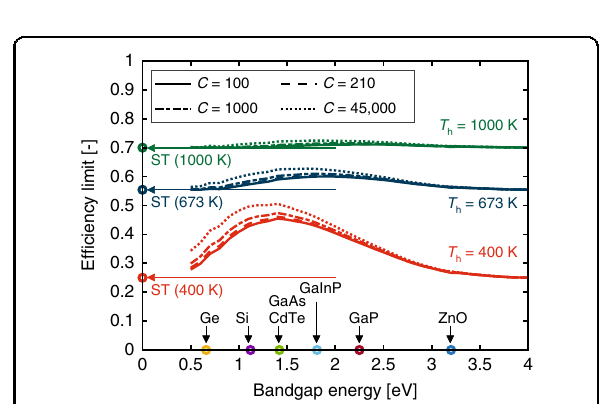
Fig. 7 Total effective ef fi ciency limits of SSPVT collectors in power-generation applications for different concentration ratios. Output temperatures T h = 400, 500, 600 and 673K correspond to w = 0.25, 0.40, 0.50 and 0.55, respectively.